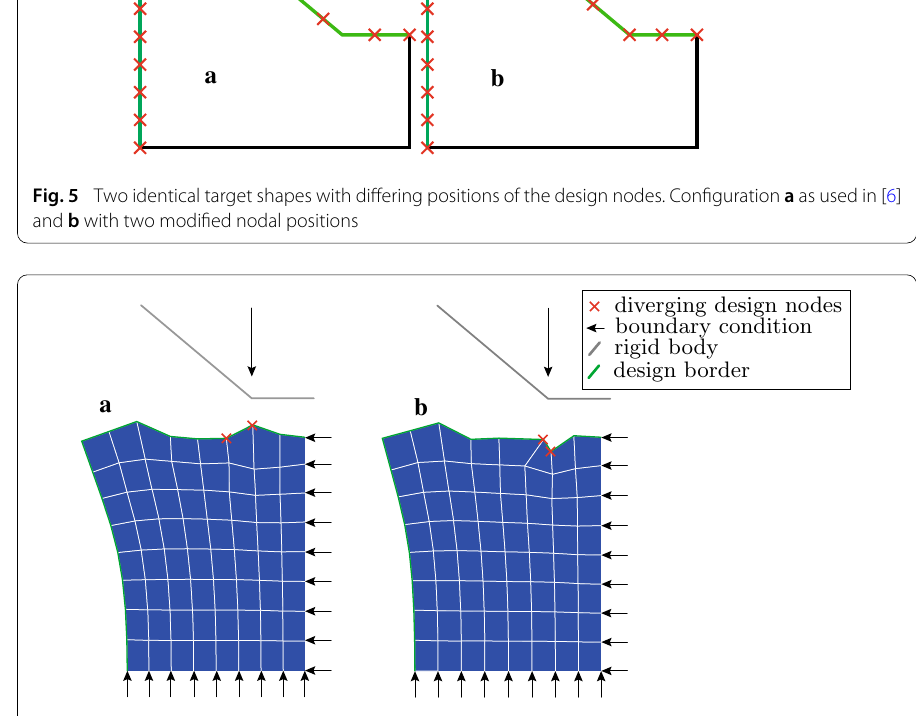
Fig. 6 Structural analysis setting with two optimized material configurations. Configuration a is based on the discretized target configuration in Fig. 5a. Configuration b is based on the discretized target configuration in Fig.